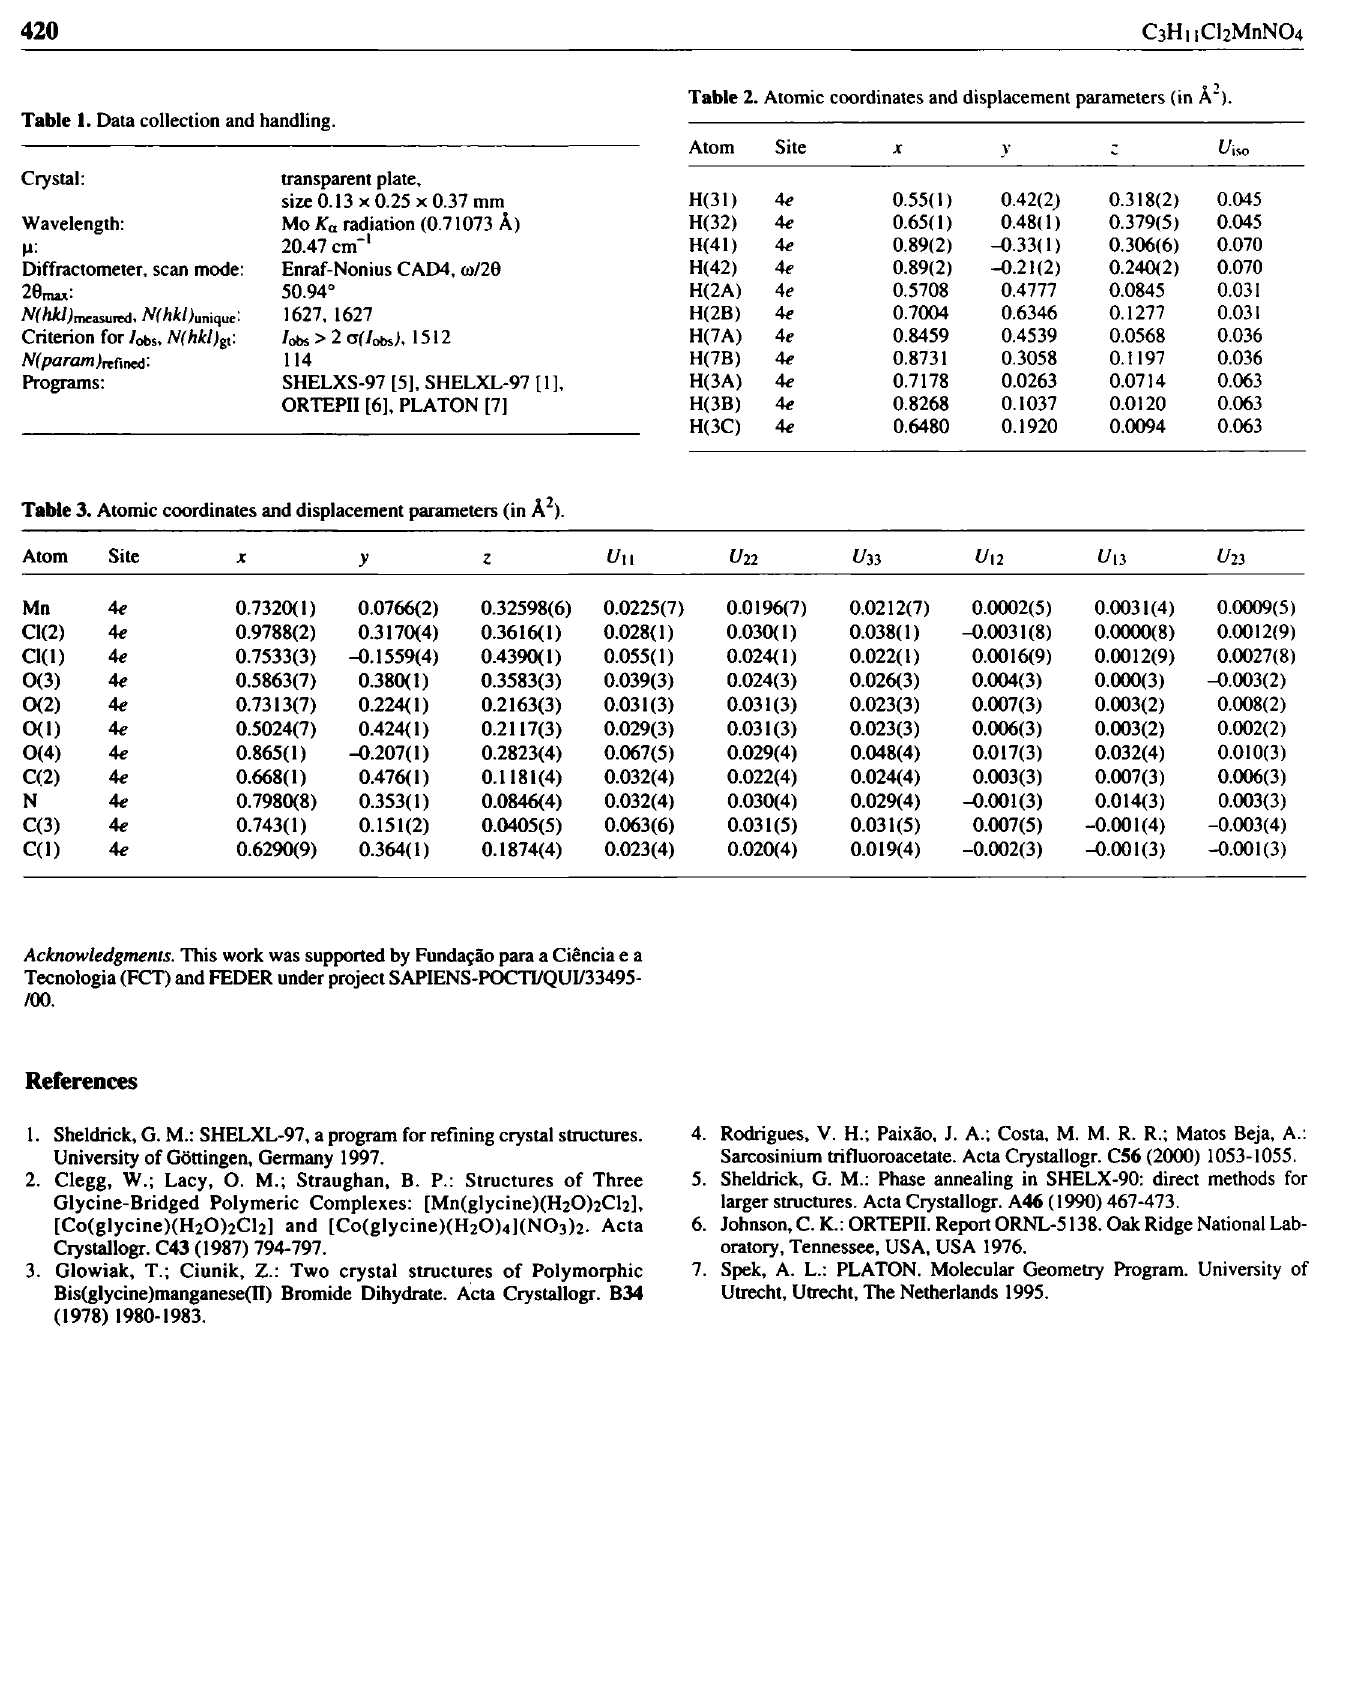
Table 1. Data collection and handling.